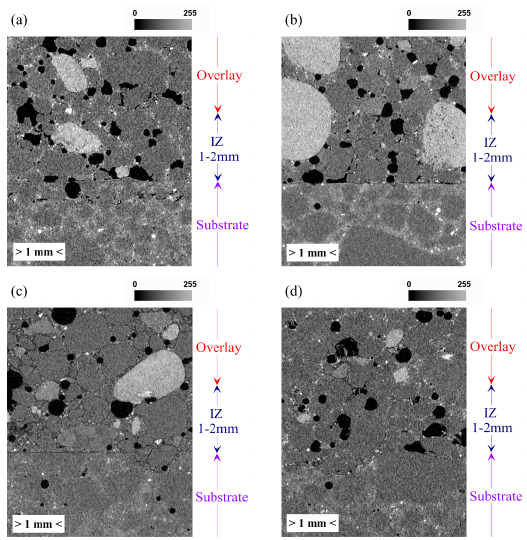
Figure 4. 2D microstructure views of the IZ between the overlay made of cement mortar and the existing concrete substrate obtained using the micro ‐ CT method at 28 days of hardening of the overlay for Samples ( a ) T1; ( b ) T2; ( c ) T3; and ( d ) T4. From the 2D microstructure views presented in Figure 4, it can be seen that there are noticeable